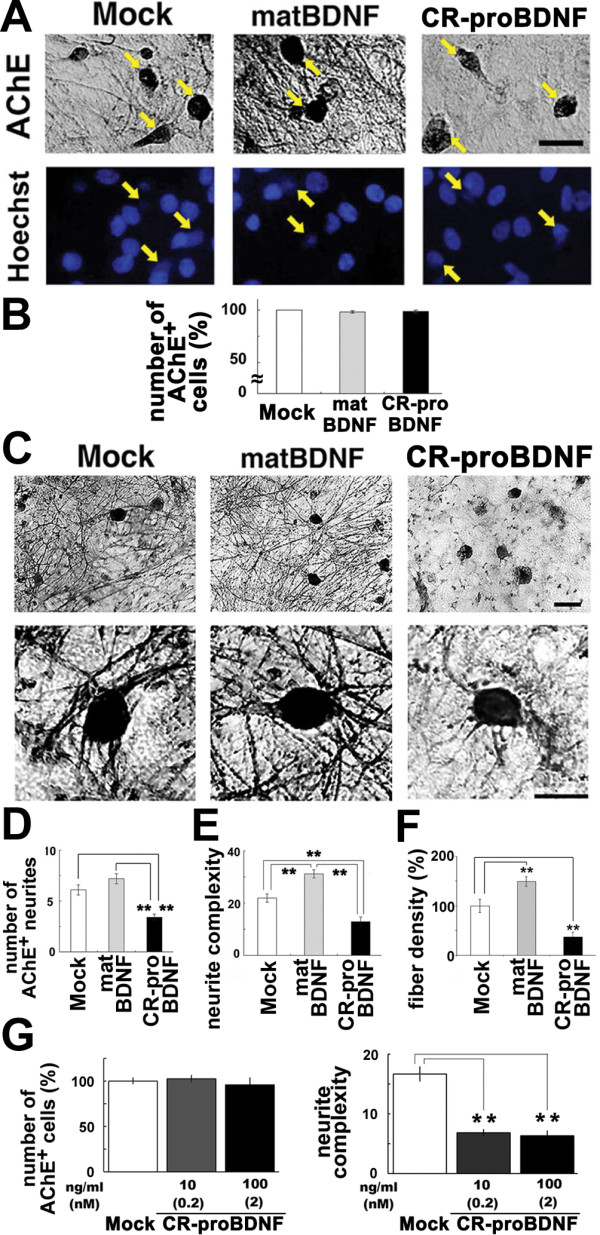
Neurite growth of basal forebrain cholinergic neurons is inhibited by CR-proBDNF, but elicited by matBDNF. BFCNs were cultured in serum-containig (A-E) or serum-free (F) medium for 2 weeks and treated with 100 ng/ml CR-proBDNF or matBDNF in the same medium condition for 2 days. Histochemistry and quantitation of AChE-positve neurites were done as described in Methods. (A) BFCNs were double-stained using AChE histochemistry and Hoechst 33258 (arrows). (B) The survival rate of BFCNs (%) = 100 × [living cells]/([living cells] + [dead cells]). Data were normalized to mock cultures (100% as control). n = 159 (Mock), 151 (matBDNF), and 149 (CR-proBDNF) from three independent coverslips. Results were replicated in three independent experiments. (C) Low- and high-magnification images of AChE-stained BFCNs. (D) The number of neurites extending outwards from the cell body shown in C. n = 38 (Mock), 37 (matBDNF), and 40 (CR-proBDNF) cells from three independent coverslips. (E) Neurite complexity as revealed by Sholl analysis. n = 30 (Mock), 30 (matBDNF), and 30 (CR-proBDNF) cells from three independent coverslips. In multi-bar graphs, ANOVA followed by post-hoc analysis was used. **P < 0.01. Results were replicated in at least three independent experiments. (F) The opposing effects of matBDNF and CR-proBDNF on neurite fiber density were confirmed by a distinct quantitative method. The maximal threshold of AChE-positive cholinergic fiber intensity was defined as 70% above the background. The total intensity of the fibers was determined in an optical field and was divided by the number of AChE-positive neurons in the same field. Data were collected from four independent fields in a single chamber. t-test, **P < 0.01, compared to Mock (100% as control); n = 6 independent culture dishes. Scale bar, 5 μm (A and C). (G) Effect of CR-proBDNF on neurite density of BFCNs in serum-free condition and a dose-dependency test of CR-proBDNF. Cell survival (left) and the neurite number of BFCNs (right) were determined. Note that proBDNF negatively regulates the neurite density of BFCNs in serum-free conditions and at subnanomoler concentration. n = 3 independent coverslips. t-test, **P < 0.01, significantly different from Mock.